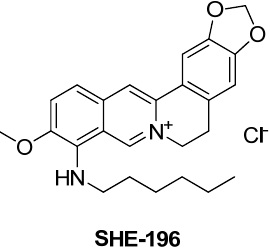
Figure 2. Structure of 9-(hexylamino)-2,3-methylenedioxy-10-methoxyprotoberberine chloride SHE-196.